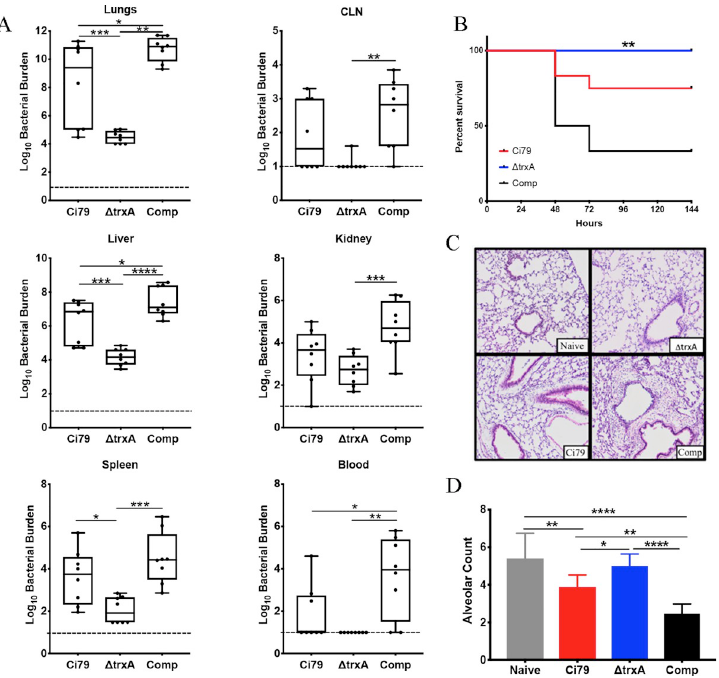
Fig 5. Comparison of pathogenesis of A . baumannii wild type (Ci79), trxA mutant, and complemented bacterial strains in a mouse pulmonary model. Mice were infected with bacteria (1x10 8 CFU/mouse) via oropharyngeal aspiration. (A) At 24 hours, mice (n = 6 per group) were sacrificed and blood and organs were collected for bacterial burden measurement. Representative of 3 independent studies. (B) Survival of bacterial-challenged mice (n = 6 per group) was monitored for 7 days. �� , P = 0.0012 (Mantel-Cox log rank test) between Δ trxA and Comp. No statistical significance was found between Δ trxA and WT. Representative of 2 independent studies. (C) For pathology, mice lungs were removed at 24 hours post challenge and fixed and embedded before sectioning and staining with H&E. Pathology was limited in all cases, although increased infiltration and thickening of alveolar walls was noted in WT and Comp. (D) To quantify pathology, differences in the number of alveolar spaces was determined by using radial alveolar counts. Error bars represent SD. Statistical differences were determined by two-way ANOVA with Holm- Sidak correction for multiple comparisons for bacterial burden (A) and alveolar space (D), ���� , P < 0.0001; ��� , P < 0.0005; �� , P < 0.005; � , P < 0.05.